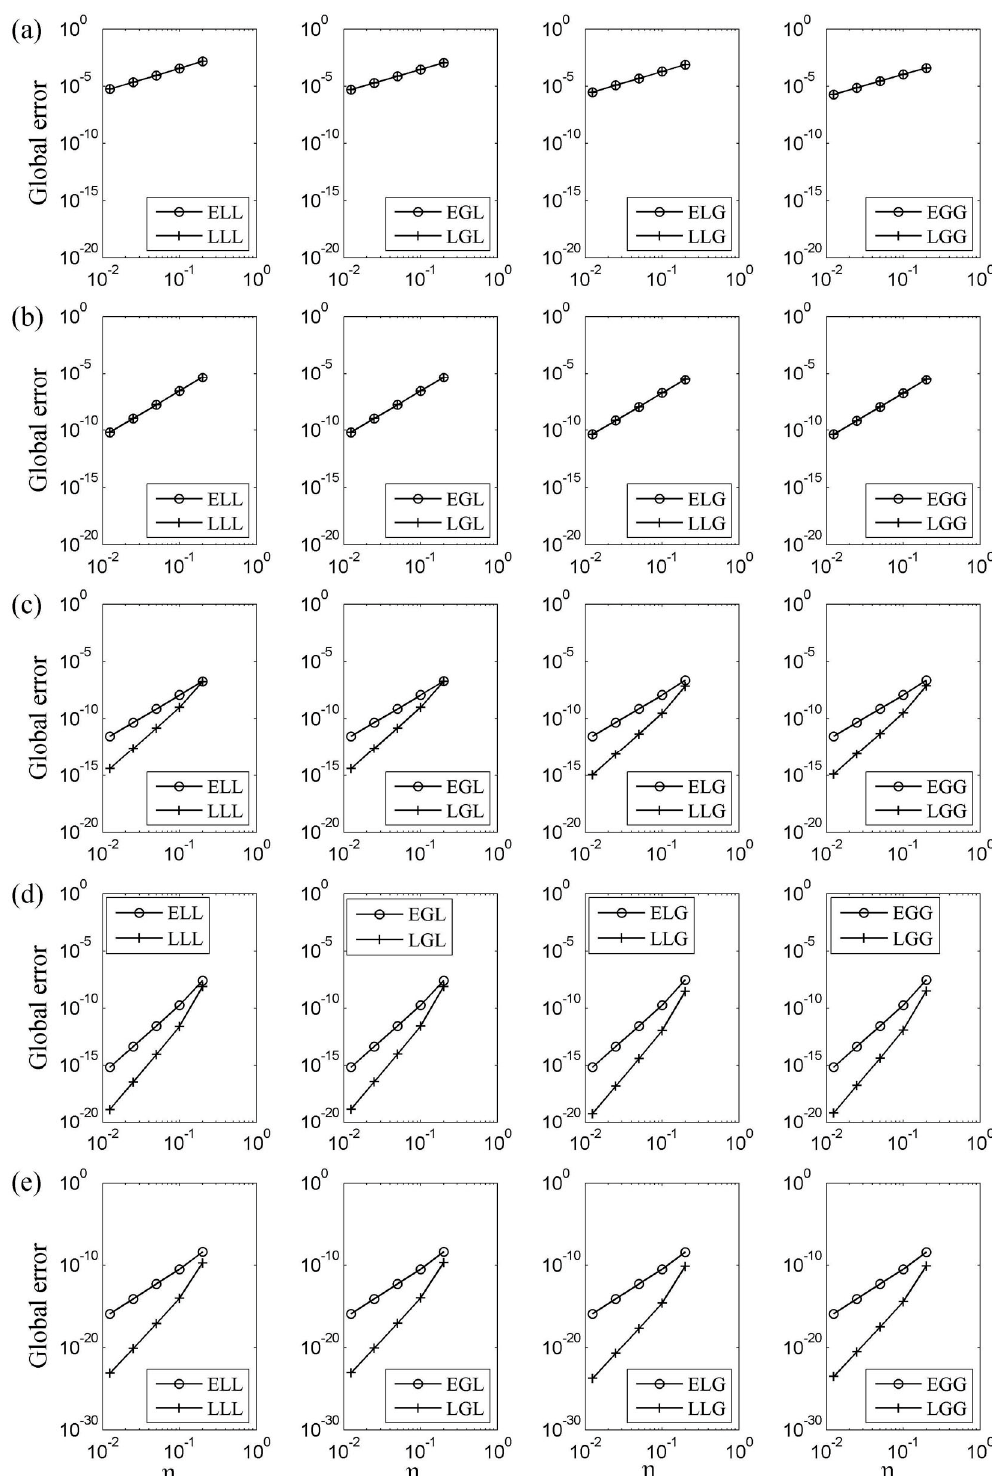
Figure 5. Triple pendulum: Log-log plot of the global error of Hamiltonian during 0 ∼ 400 s with ( a – e ) corresponding to m = 2, 3, ··· , 6, respectively.